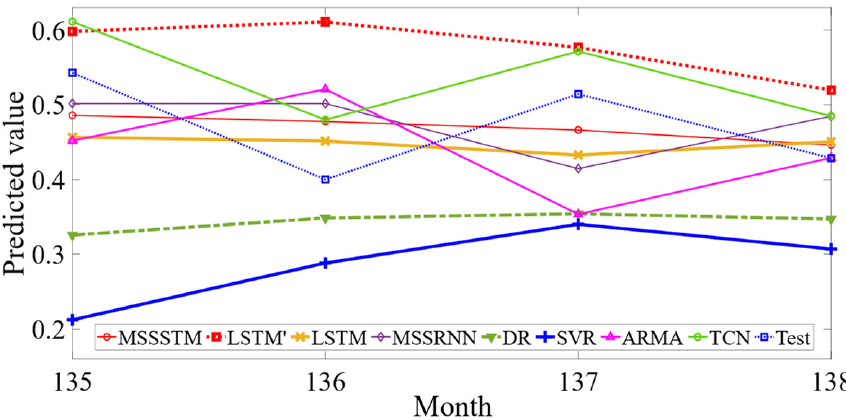
Figure 11. Comparison of the predictive model results.